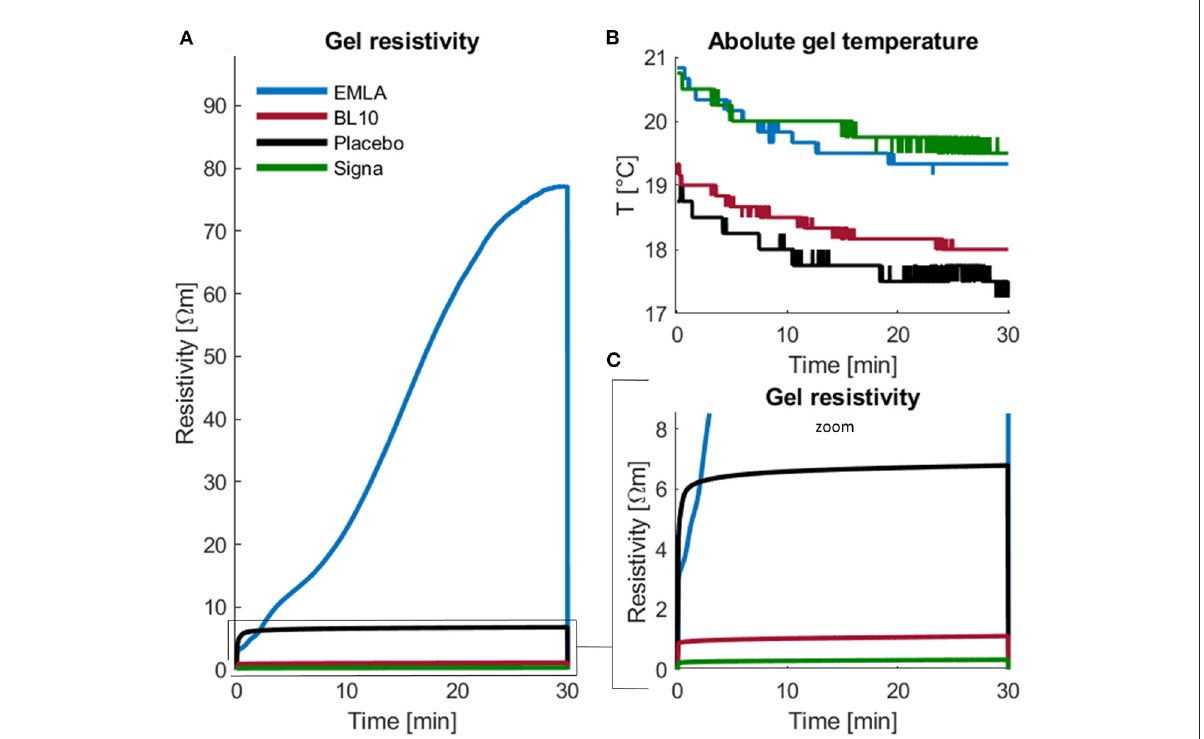
FIGURE5 Effect of DC current on gel resistivity and temperature. In an in-vitro experiment, a DC current of 2mA was applied over samples of the BL10 gel (red), EMLA gel (blue), placebo gel (black), and Signa gel (green) for 30min. (A) Gel resistivity was relatively stable for all gels except for the EMLA gel, which showed a larger increase. (C) The resistivity of the BL10 gel was similar to the resistivity of the conductive Signa gel, whereas the resistivity of the placebo gel was slightly higher. (B) Temperature measurements showed that the gel temperature decreased steadily over time to room temperature. The illustrated results are the calculated average of three independent measurements, see Supplementary